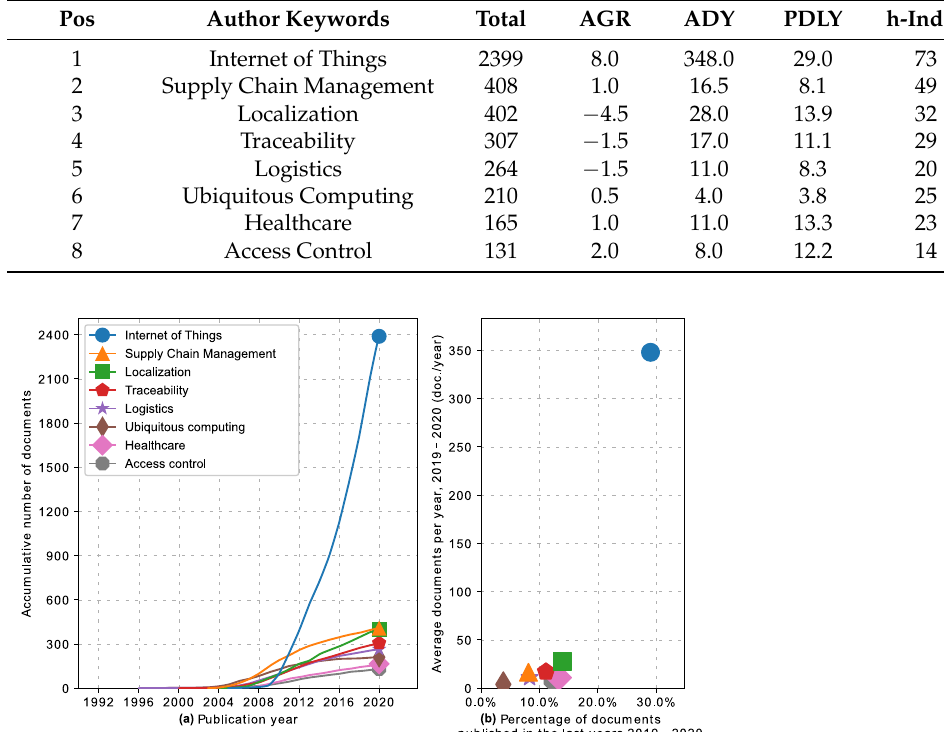
Table 2. Top author keywords for RFID applications.